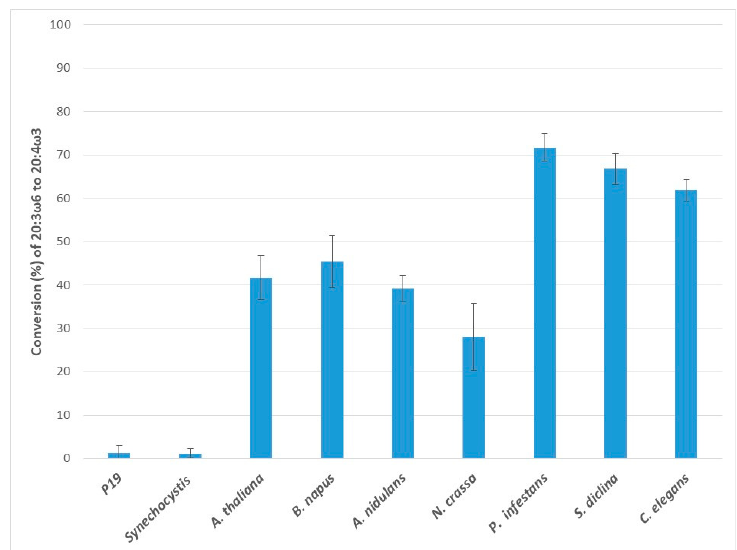
Figure 3. Enzymatic activities of transiently expressed ω 3Ds from various sources in N. benthamiana leaves on 20:3 ω 6 substrate. ω 3D activities were determined by measuring the conversion rate of provided 20:3 ω 6 substrate to 20:4 ω 3 in leaves expressing p19 silencing suppressor only as a control or the appropriate ω 3D with p19. The error bars denote the standard deviations of the means from triplicate assays.